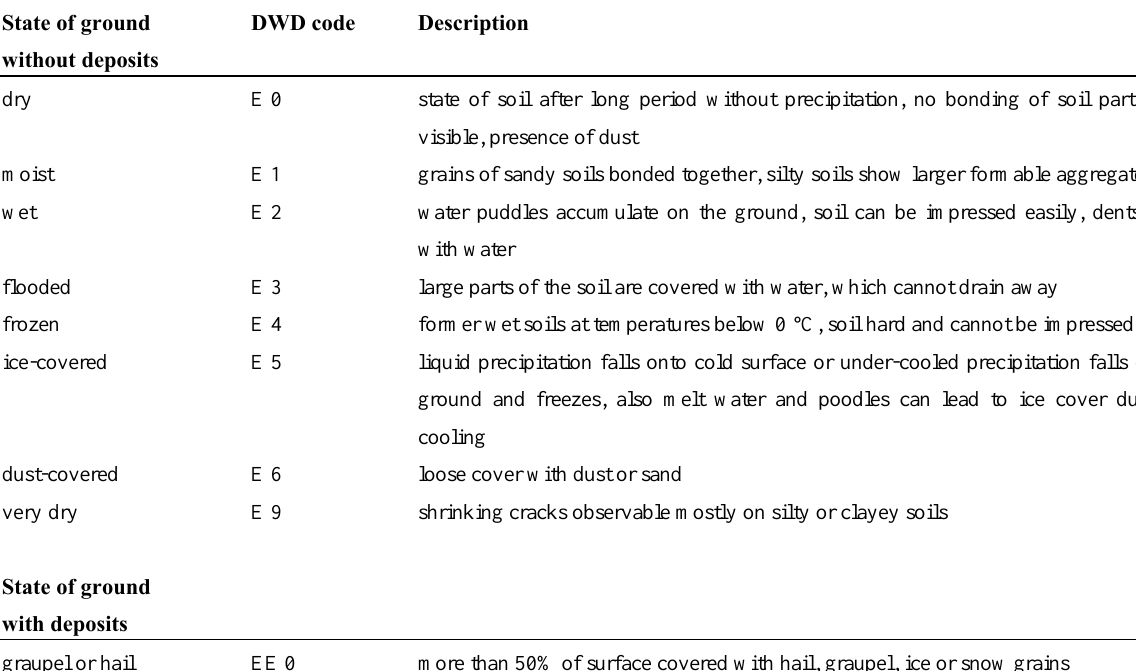
Table 1. Different SOG with corresponding codes of the DWD and its descriptions for visual